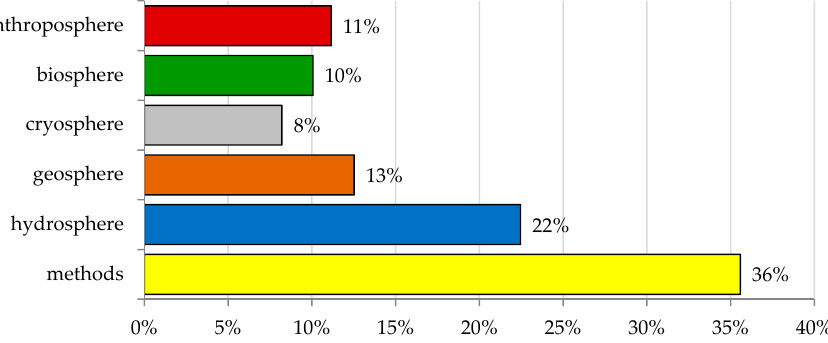
Figure 13. Histogram of TerraSAR-X related fields of research, expressed in percent based on the analysis of 2850 publications.